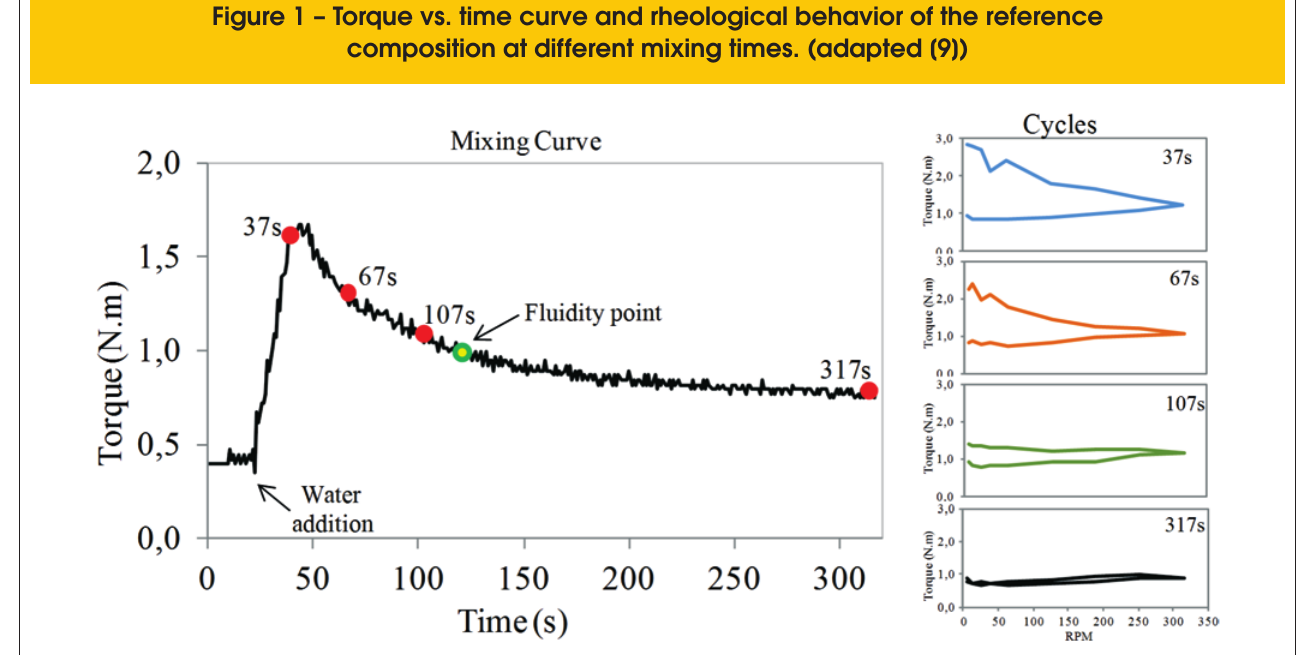
Figure 1 – Torque vs. time curve and rheological behavior of the reference composition at different mixing times. (adapted